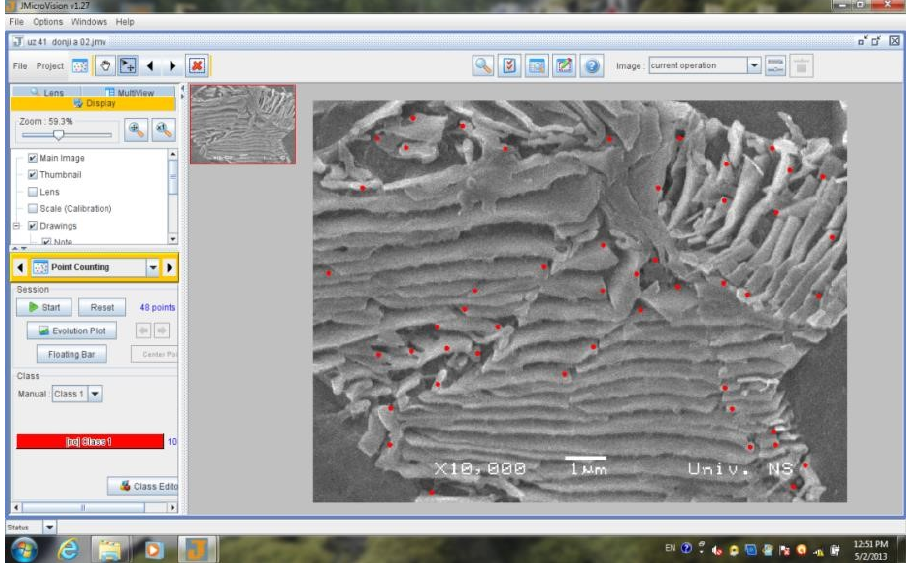
Figure 13. Identification of damage in pearlite colonies using JMicroVision v1.27 software. Table 3. Quantification of microcracks in pearlite colonies.